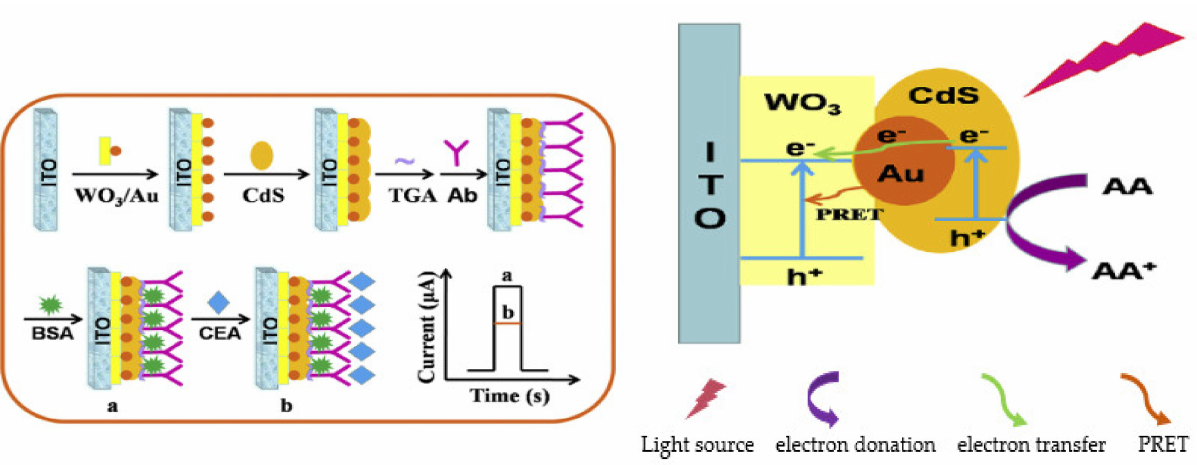
Figure 21. Schematic diagram of the fabrication procedure of a PEC immunosensor and possible charge transfer mechanism at WO 3 /Au/CdS interface in the presence of ascorbic acid (AA) as electron donor. e: electron; h: hole; PRET: Plasmon resonance energy transfer. Reprinted with permission from [136], published by Elsevier,